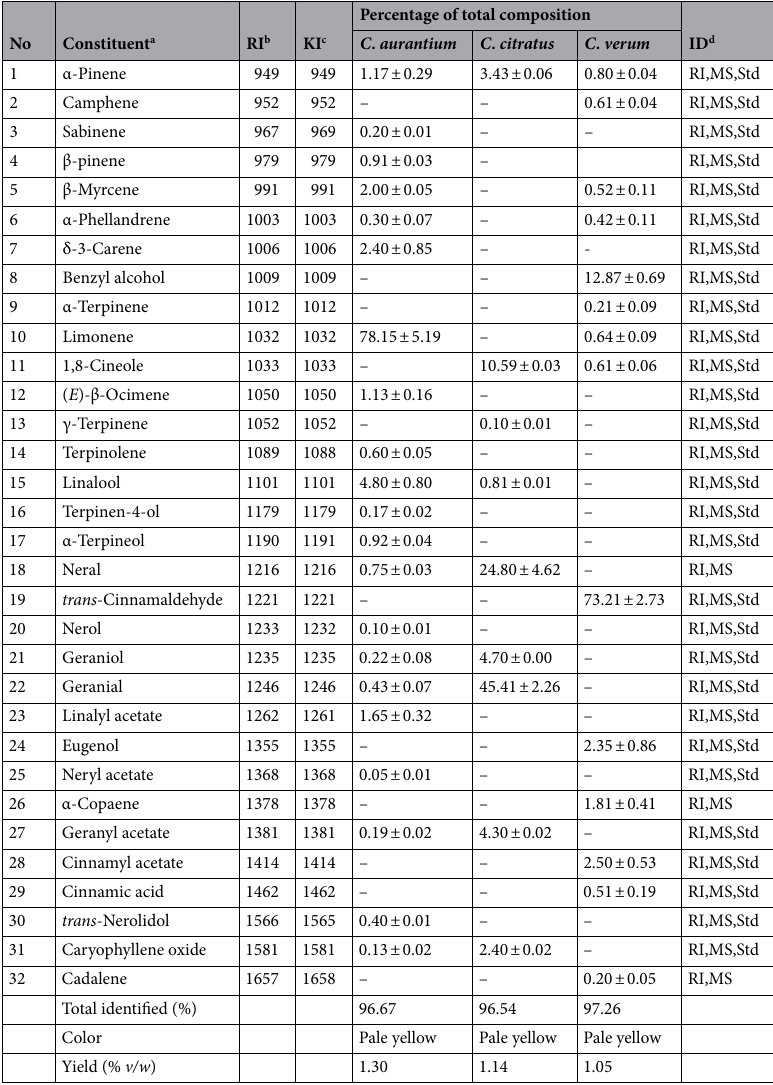
Table 1. Chemical composition of the essential oils Cinnamomum verum , Citrus aurantium , and Cymbopogon citratus . a Constituents listed in order of elution in the HP-5MS column. b RI Retention index calculated through the retention time in relation to the series of C 7 –C 30 n-alkanes. c KI Kovats retention index is taken from https:// pubch em. ncbi. nlm. nih. gov. d ID identification method: std: substance matching was done with a